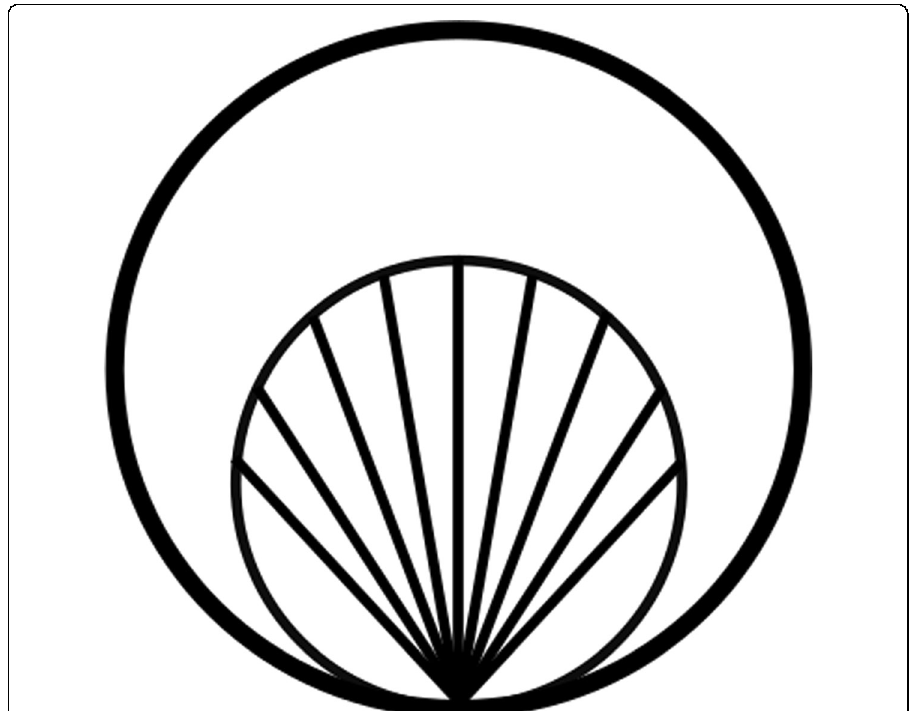
Fig. 13 Legend: The big circle presents the space of the EU, the smaller circle presents regions in EMMA, and lines indicate boundaries between regions in